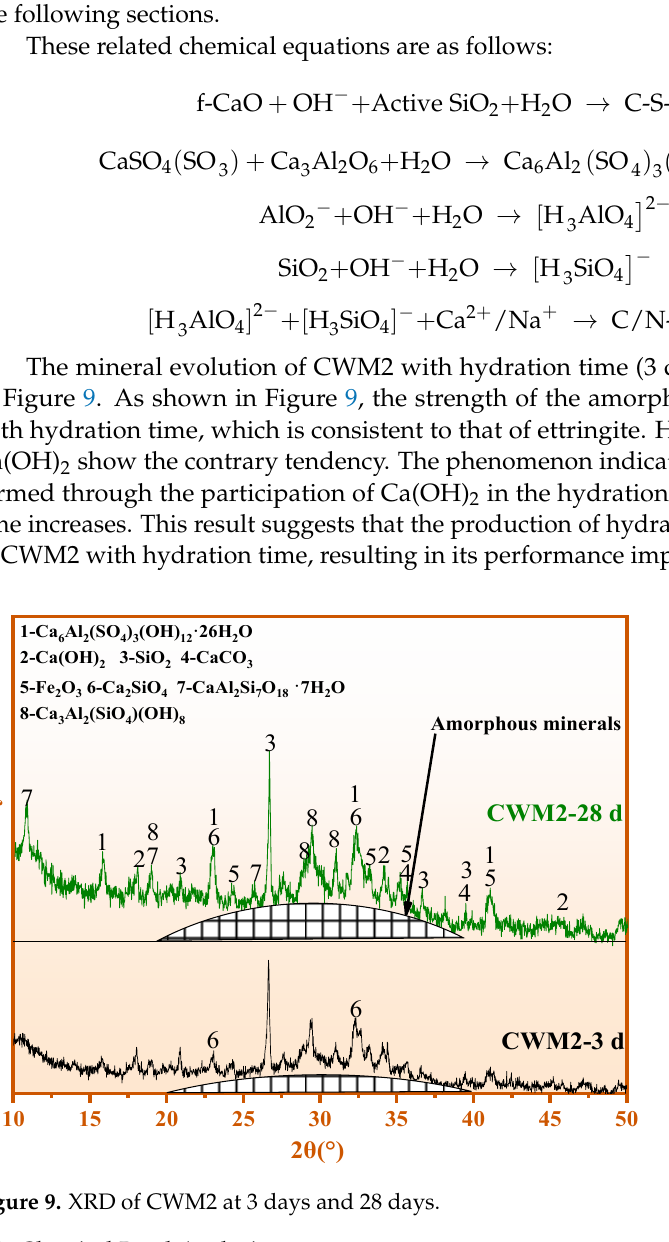
Figure 8. XRD patterns of the three CWMs at 28 days.